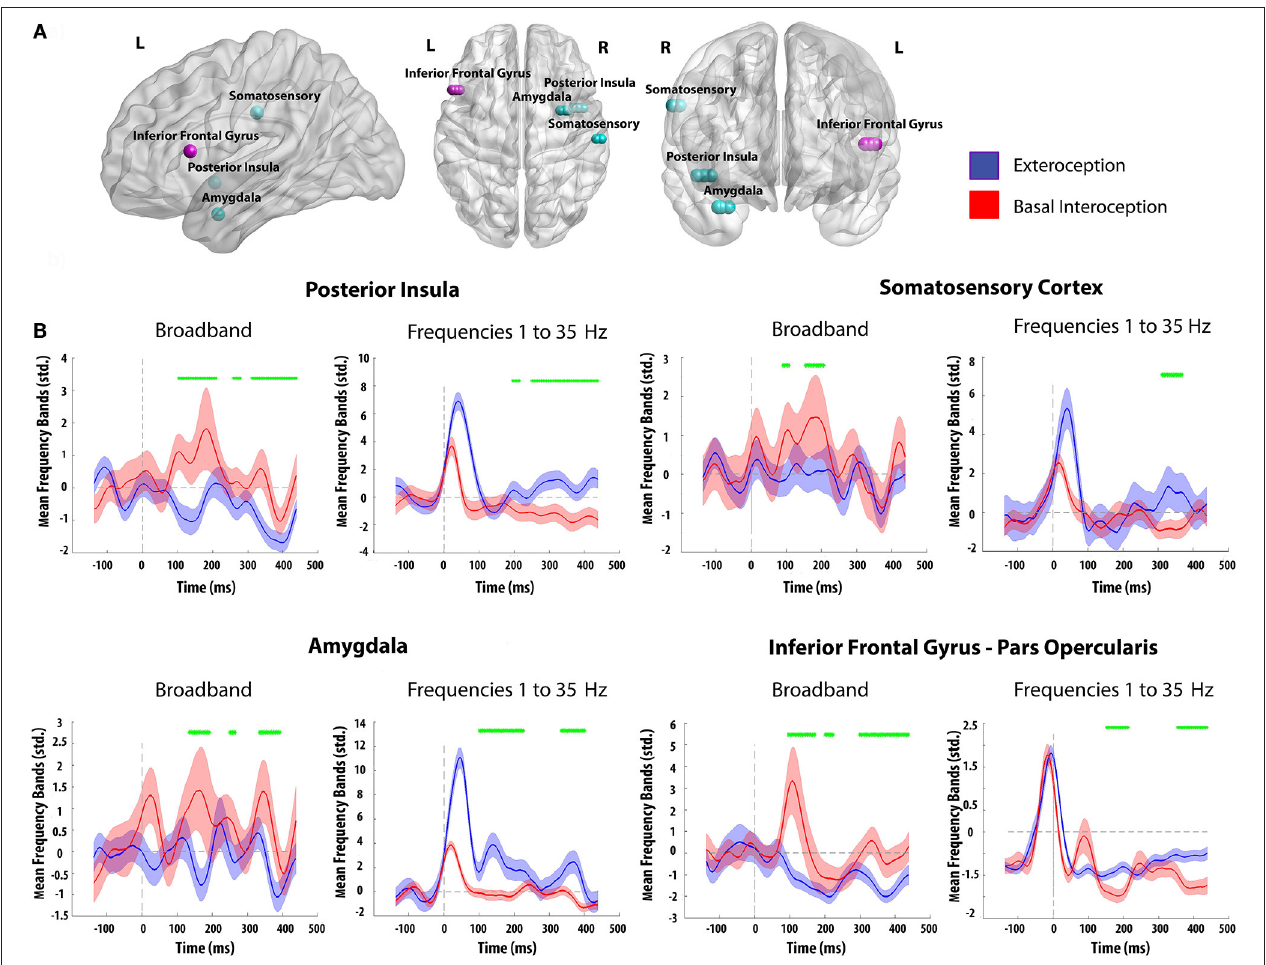
FIGURE 4 | (A) Electrode contact sites of both subjects. Each color represents a different patient (Light Blue: Patient 1; Pink: Patient 2). (B) Time frequency analysis for basal interoception and the exteroceptive condition using different frequency ranges. Green marks identify significant values between conditions ( p < 0.05, as in Hesse et al., 2016). Differences not reaching five consecutive points were eliminated; shadows indicate